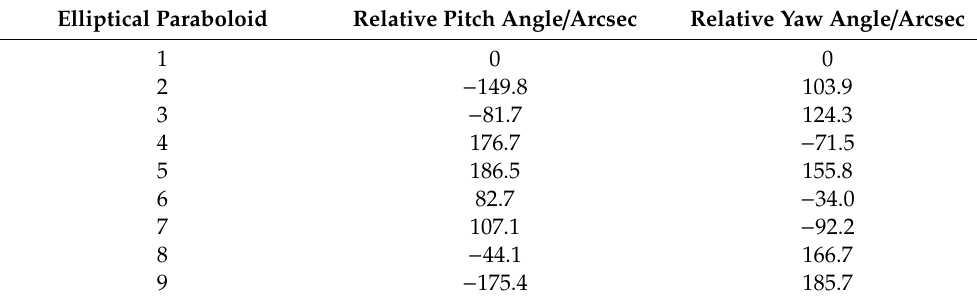
Table 1. Calibration results of the relative pitch angle and yaw angle.